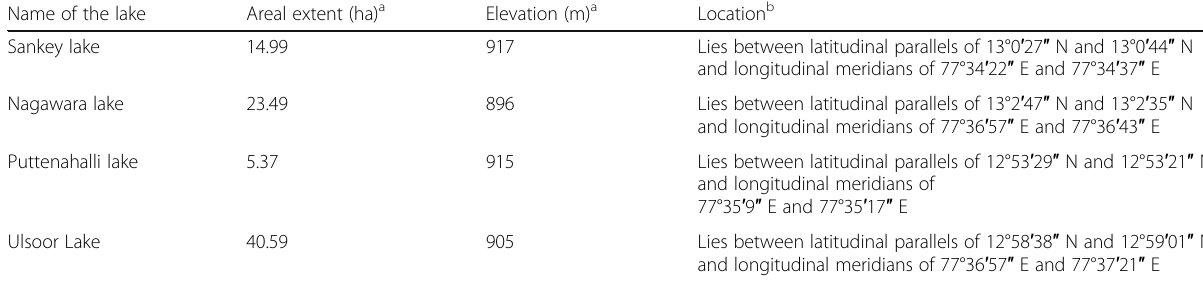
Table 1 Areal extent, elevation and coordinates of the lakes Name of the lake